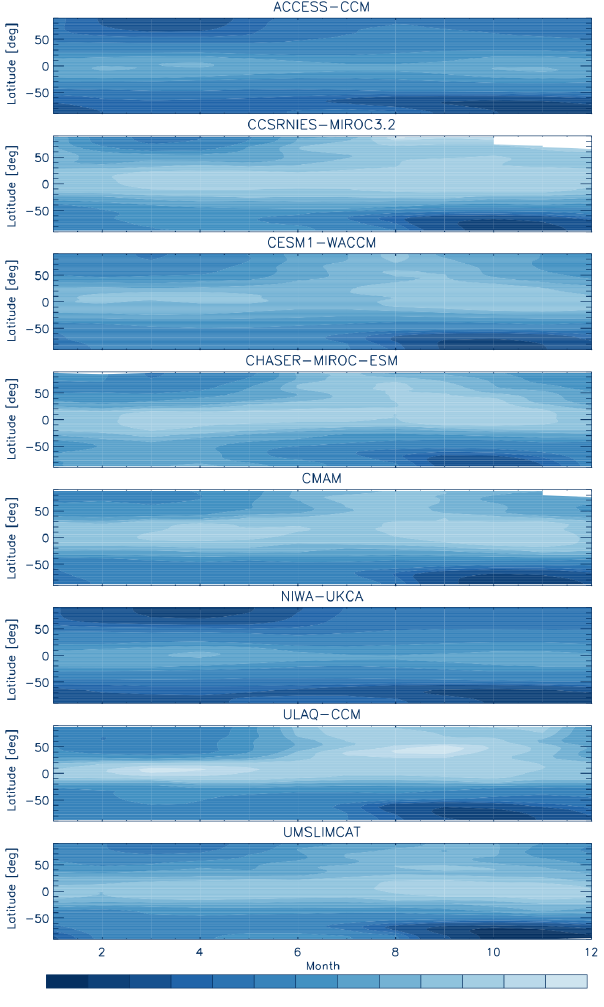
Figure 8. Same as Fig. 2 but for Cleq . , in units of DUppbv − 1 (Cleq . ), derived from the REF-C2 and SEN-C2-fODS simulations.